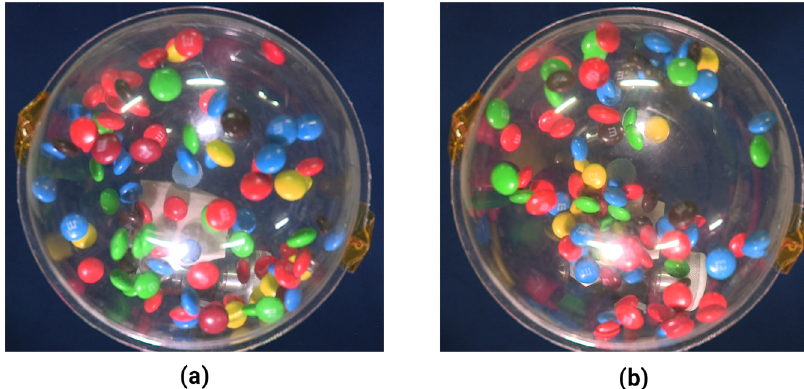
Fig. 2 Particle clustering. In four out of the total fi ve experiments we observe fi rst a homogeneous distribution of the particles as shown by a , and then a separation of the particles into dense and dilute regions as shown by b